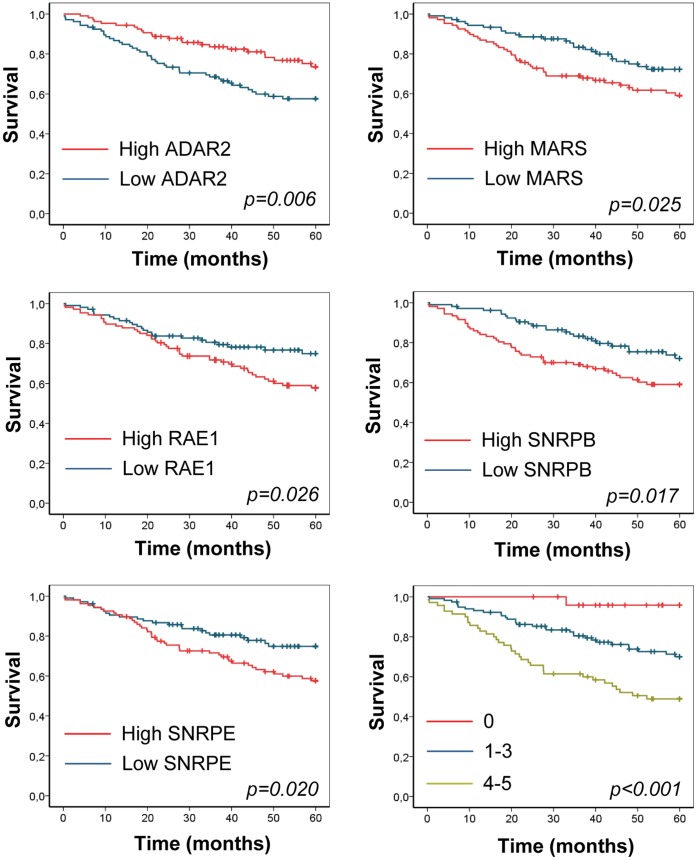
Association between RNA metabolism-related genes and clinical outcome of patients with lung adenocarcinoma.Data were obtained from a microarray study [26]. Figures show Kaplan-Meier curves and log rank statistics for overall survival in patients divided in high and low mRNA expression (using the median as the cut-off point). Last figure corresponds to patients divided by the number of deregulating events (see Material and Methods).